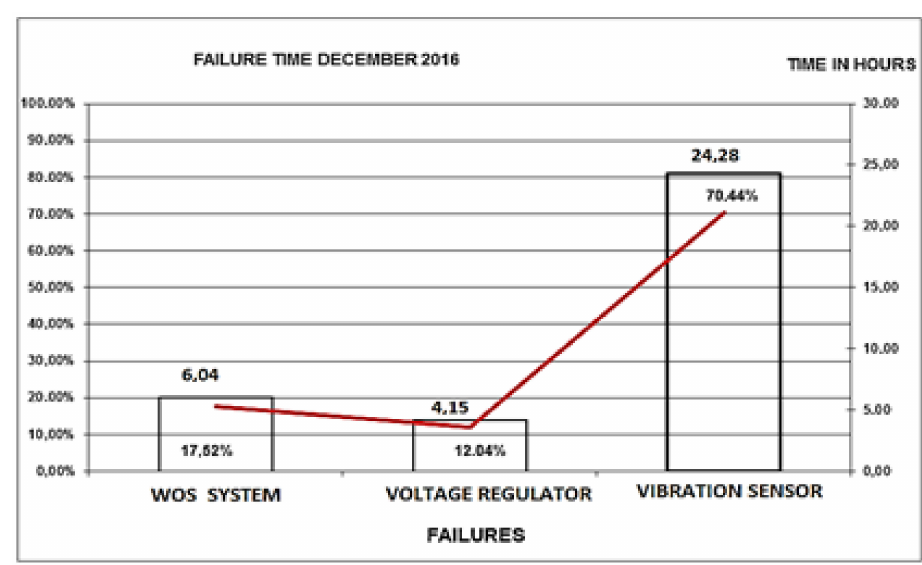
Figure 13. Failure time indicators, December 2016.